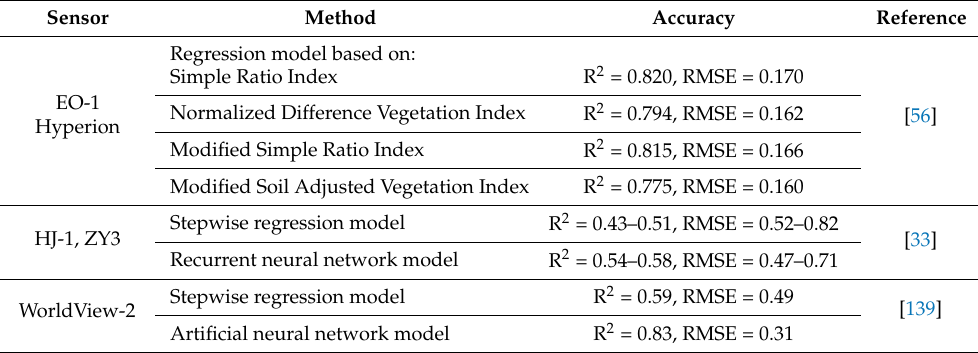
Table 8. Comparison of method and accuracy for leaf area index (LAI) studies in rubber